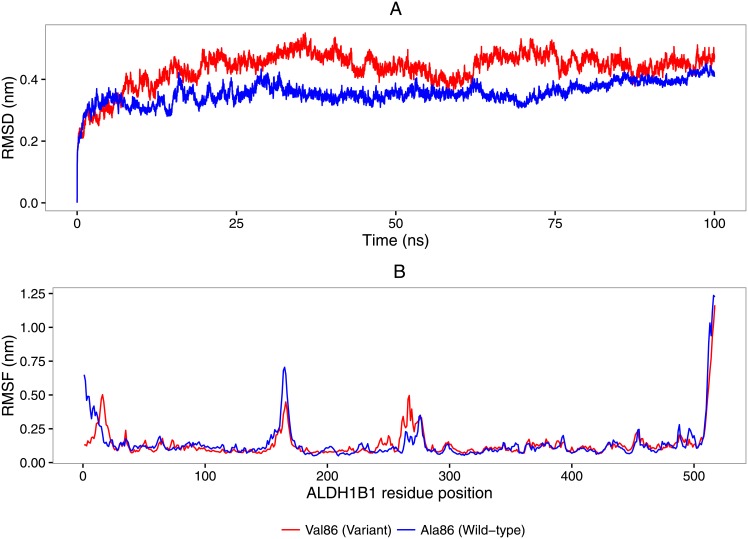
Molecular dynamics simulations performed on the structural homology models of the wild type and the 86Val variant structure of ALDH1B1.A—The RMSD* of carbon α backbone atoms over the course of the entire 100 ns molecular dynamics simulation for the wild-type (blue) and Val86 variant (red) structure. B—The RMSF** of carbon α backbone atoms over the last 90 ns of the molecular dynamics simulation for the wild-type (blue) and Val86 variant (red) structure. * The root mean squared deviation (RMSD) is a measure the average distance between a number of atomistic positions between a reference structural model and the structural model at a point in time during the simulation. Its variability over the time-course of the simulation indicates the scale of atomistic movement in a structural model and whether it has achieved dynamic equilibrium. ** The root mean squared fluctuation (RMSF) is a calculation of the average RMSD in a well-defined atomistic position, typically atoms present in key regions of the protein structure, over a specified time-period of the simulation. The RMSF highlights differences in movement between in a protein structure over a time period of a simulation and is useful for comparing two or more simulation trajectories.